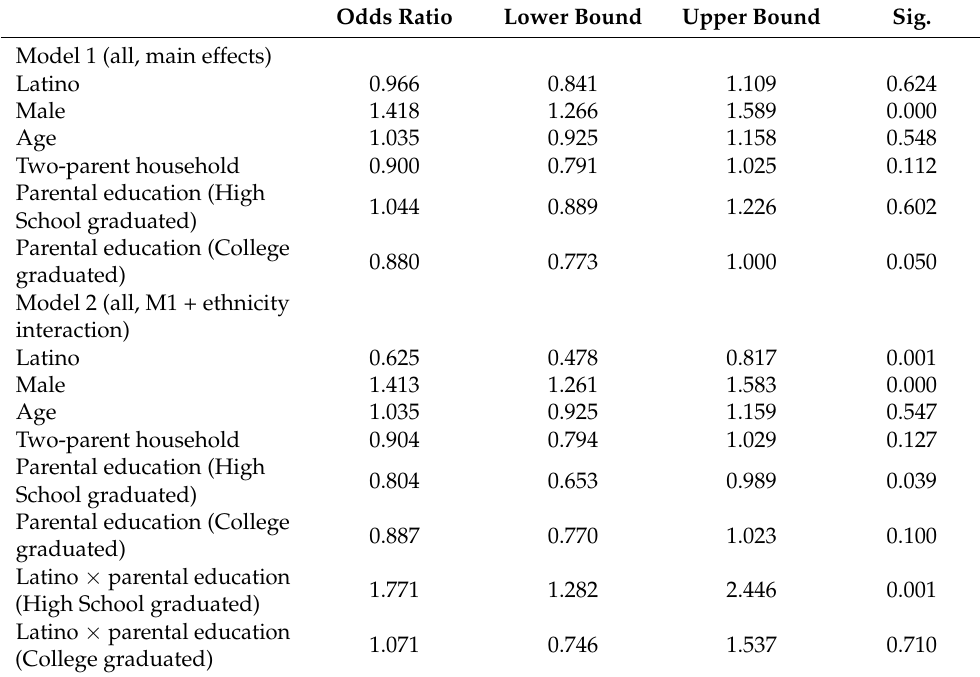
Table 2. Pooled sample models in US adolescents.